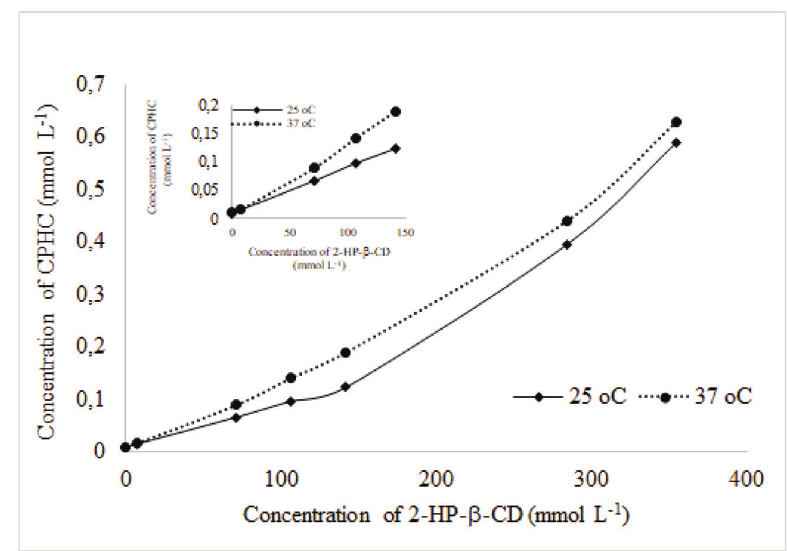
FIGURE 7 - Phase solubility diagram of 3-(3-(2-chlorophenyl)prop-2-enoyl)-4-hydroxycoumarin and 2- hydroxypropyl-β- cyclodextrin in purified water at 25 °C and 37 °C ± 0.1